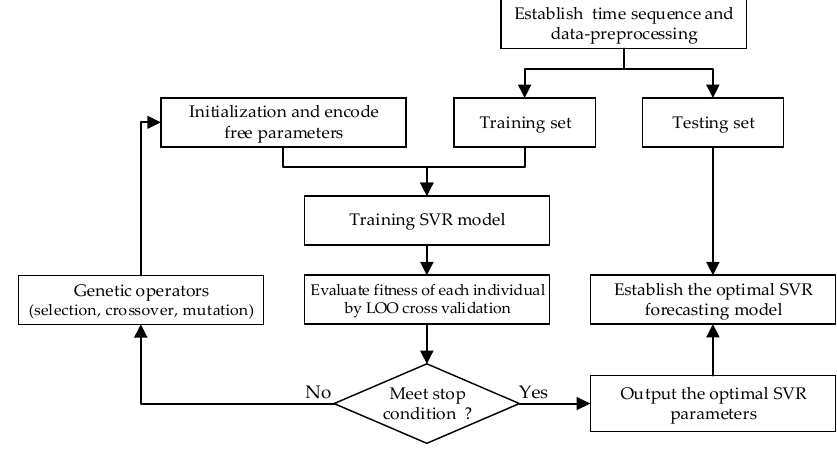
Figure 5. Flowchart of parameter optimization of MKF-SVR.